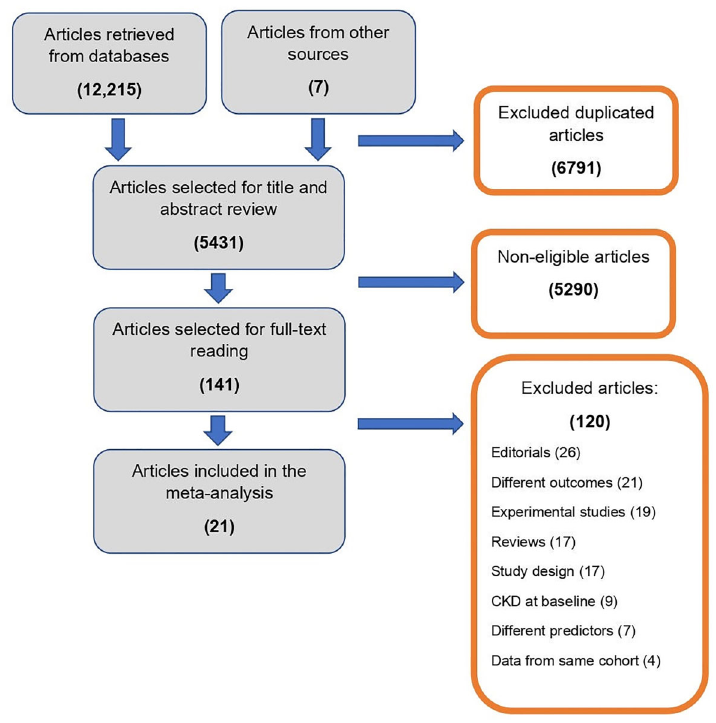
Figure 1. Flowchart of study selection by systematic review. CKD: chronic kidney disease.